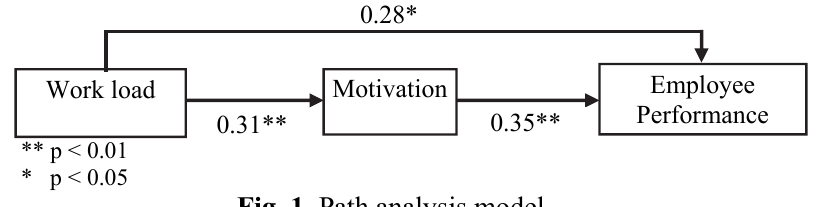
Fig. 1. Path analysis